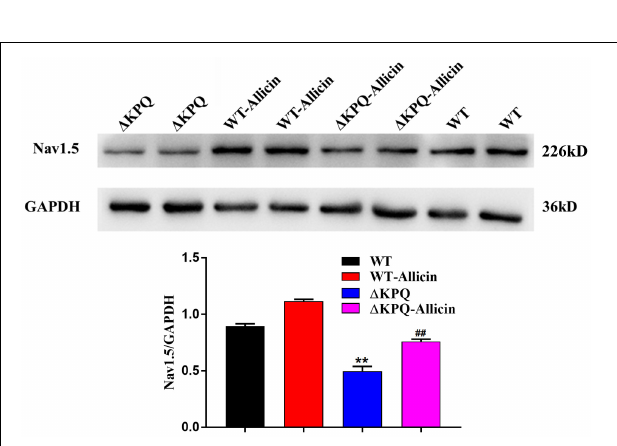
FIGURE 5 | Effect of Allicin on the Nav1.5 channel protein expression of the (cid:49) KPQ-SCN5A mutation. A Western Blotting showed that the Nav1.5 channel protein expression in cell membrane of the (cid:49) KPQ-SCN5A mutation was increased from 0.49 ± 0.04 to 0.76 ± 0.02 under the effect of 30 µ M Allicin, which was close to 0.89 ± 0.02 of the WT. ∗∗ P < 0.01 vs. WT group; ## P < 0.01 vs. (cid:49) KPQ